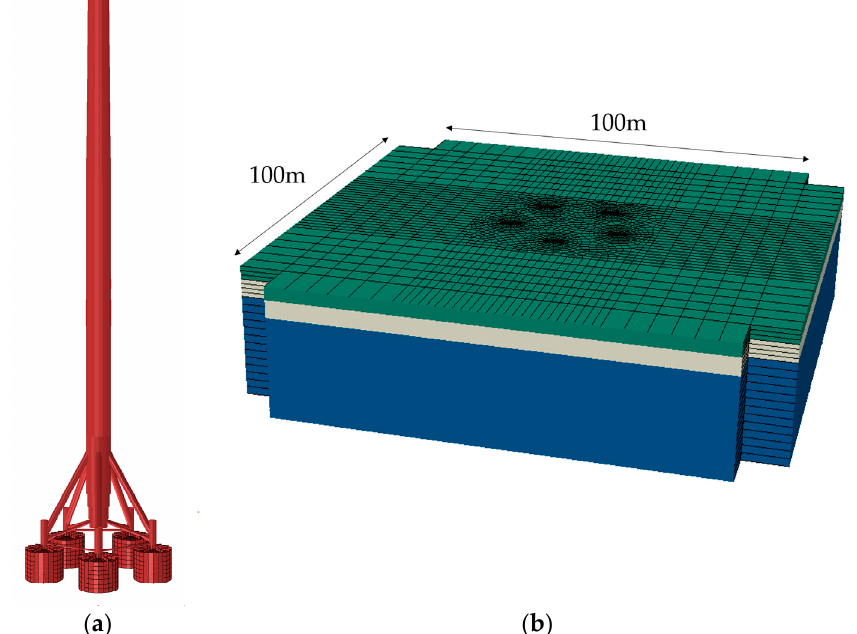
Figure 3. Illustration of analysis models ( a ) OWT model and ( b ) soil model. Table 1. Steel properties.